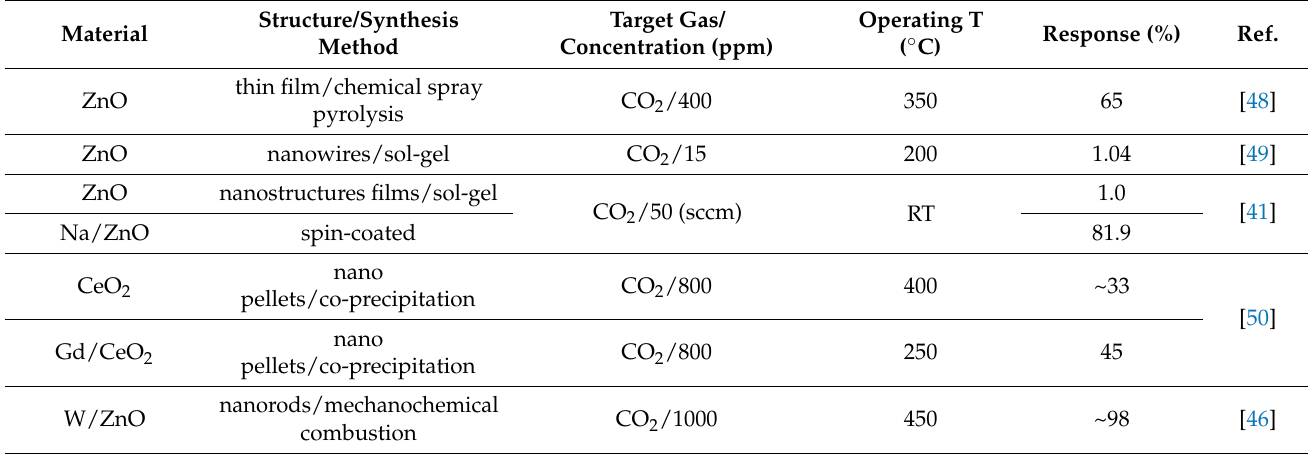
Table 4. Brief summary of metal oxide semiconductor-based CO 2 gas